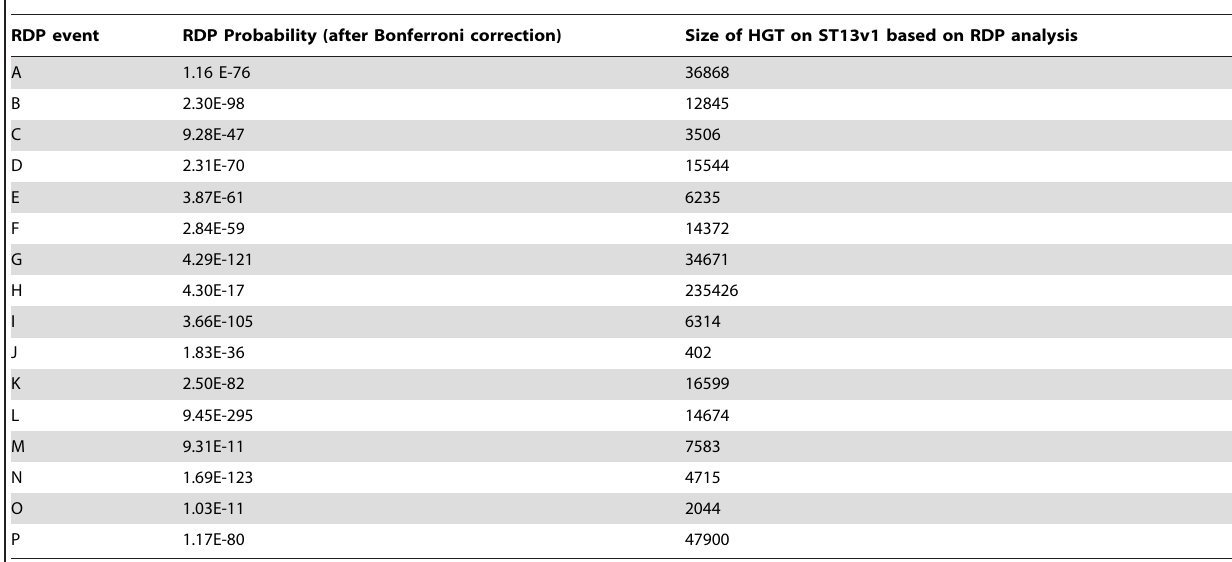
Table 3. Recombination fragments predicted by RDP3 analysis, their corresponding probabilities after Bonferroni correction, and estimated size in base pairs.